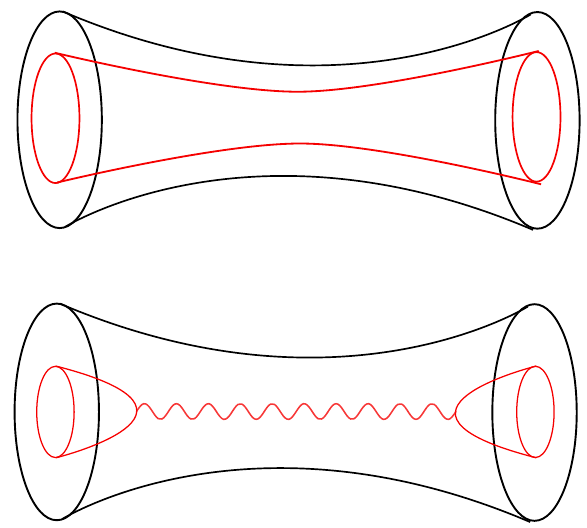
Figure 12 . The di(cid:11)erent behaviours of a loop-loop correlator. In both cases the correlator scales as O ( N 0 ). As the world-sheet connecting the loops approaches the string length in the middle of the throat, the single surface con(cid:12)guration ceases to be trustworthy. In the second disconnected case the loops can interact only via exchange of gravitons and other perturbative bulk